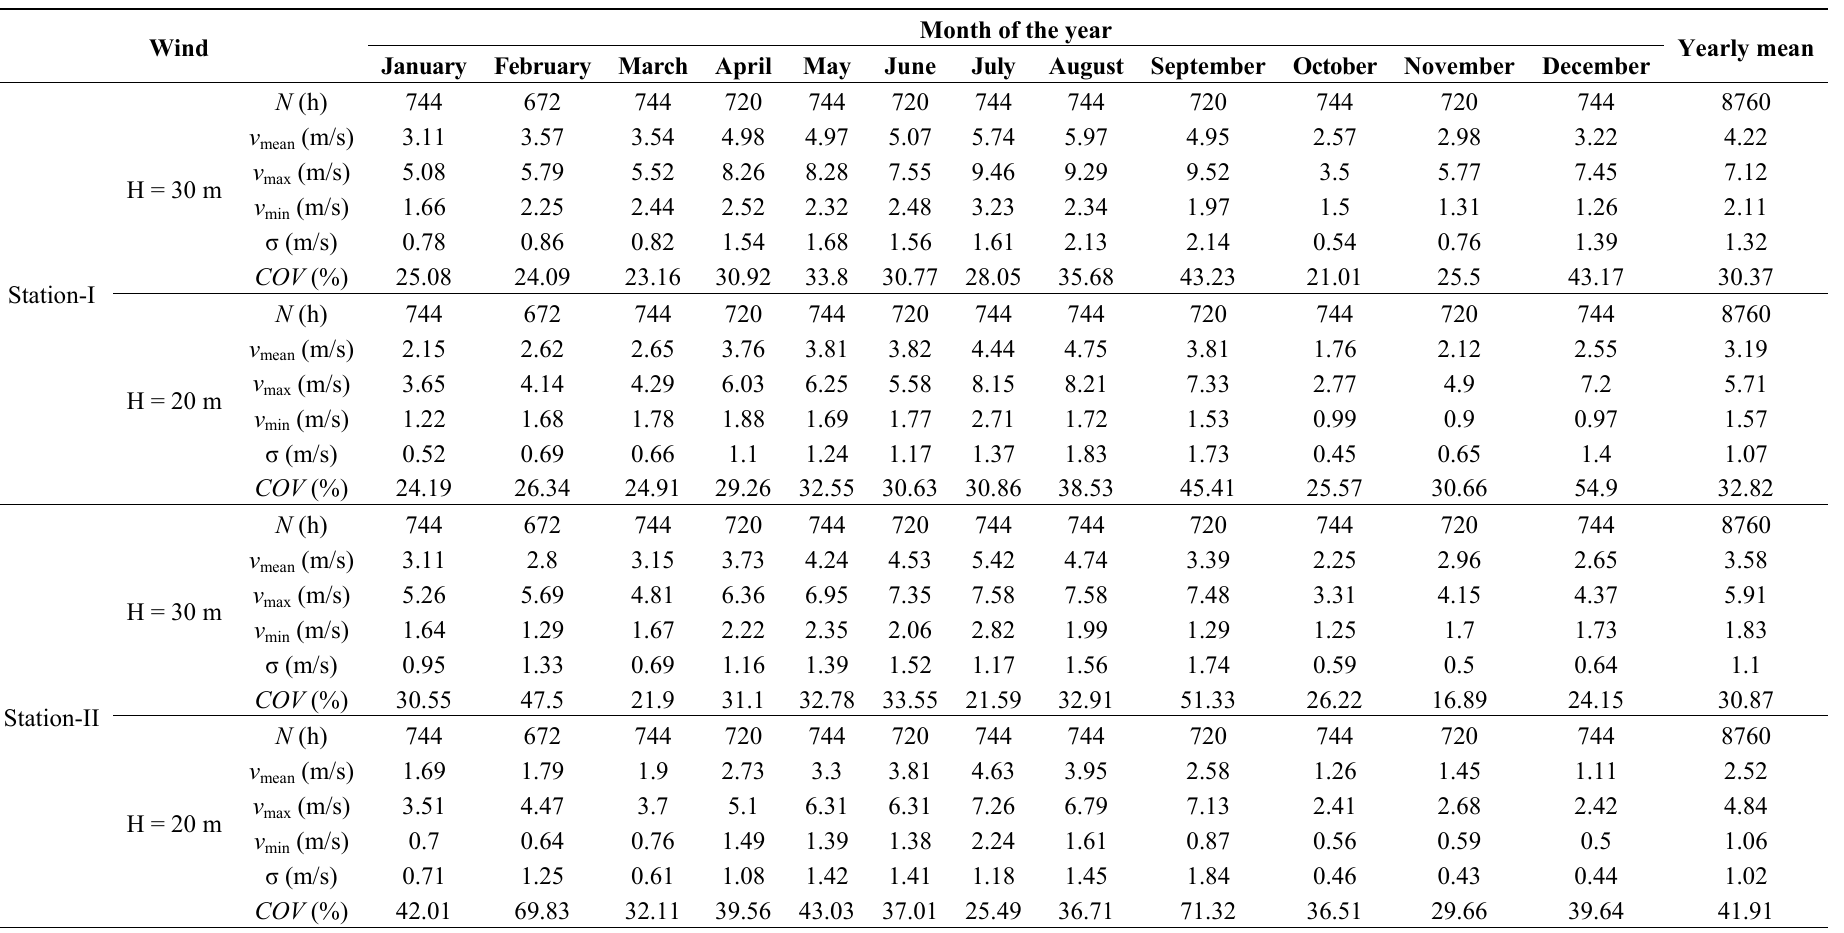
Table 2. Monthly mean wind speed (m/s) data for selected wind stations at 20 m and 30 m height. COV : coefficient of